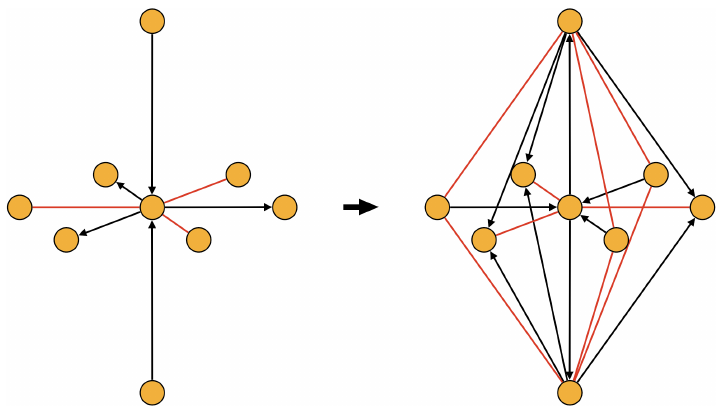
= n F = 3 . The k k,out